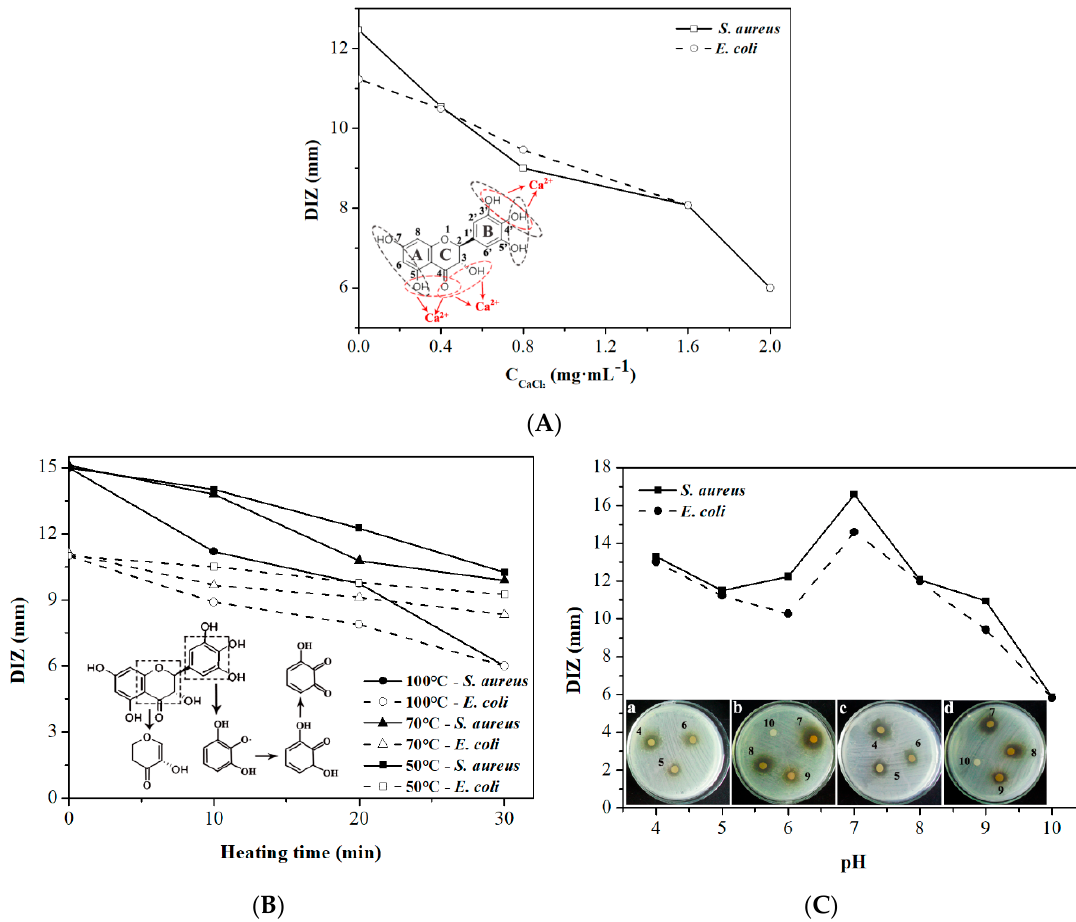
Figure 2. The effects of ( A ) Ca 2+ , ( B ) thermal processing, and ( C ) pH on the activities of DMY against Figure 2. The e ff ects of ( A ) Ca 2 + , ( B ) thermal processing, and ( C ) pH on the activities of DMY against E. coli and S. aureus . E. coli and S. aureus